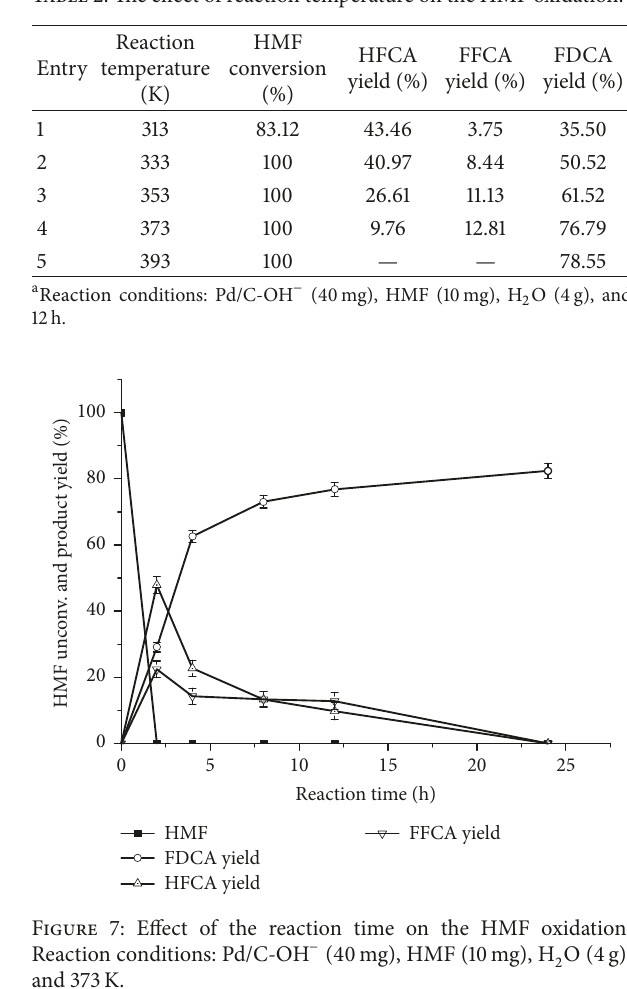
Table 2: The effect of reaction temperature on the HMF oxidation. a